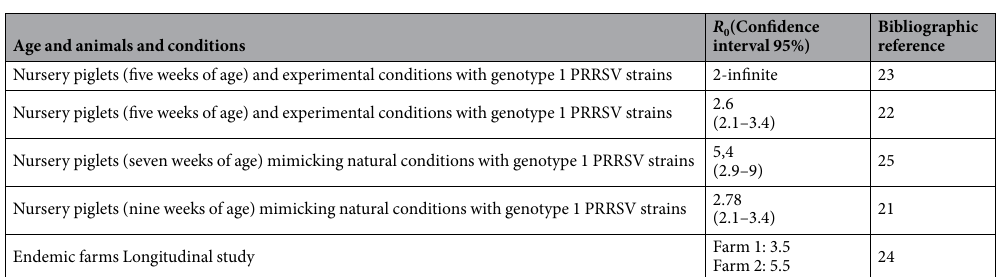
Table 7. Available literature to select the reproduction rate (R 0 ) as a key epidemiological parameter in this research work.